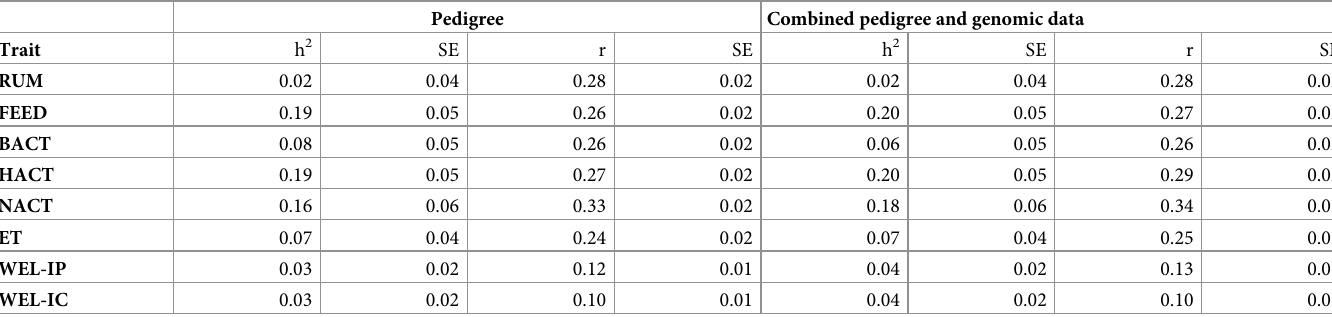
Table 1. Heritabilties (h 2 ) and reliabilities (r) with standard errors (SE) for sensor behavior traits.